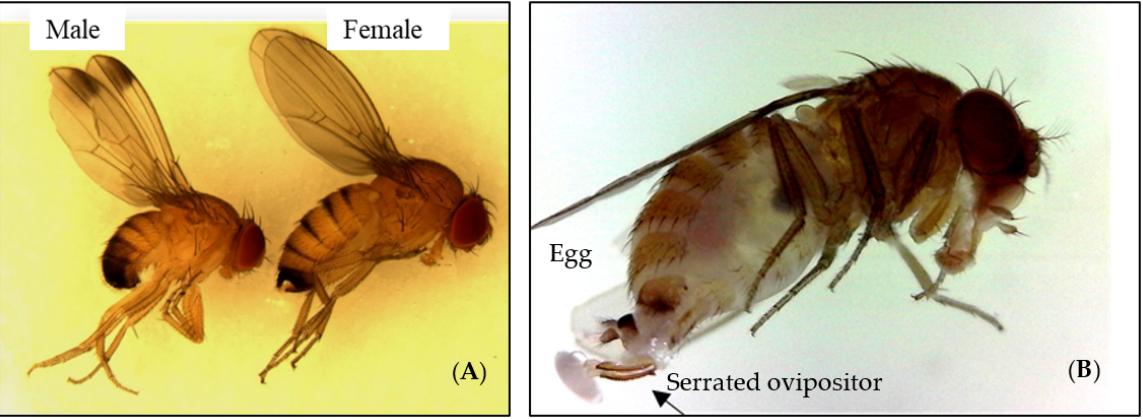
Figure 1. ( A ). male (wings with spots at the apex) and female (no wing spots) adults of D. suzukii , ( B ). Arrow showing the serrated ovipositor with rice-shaped egg.